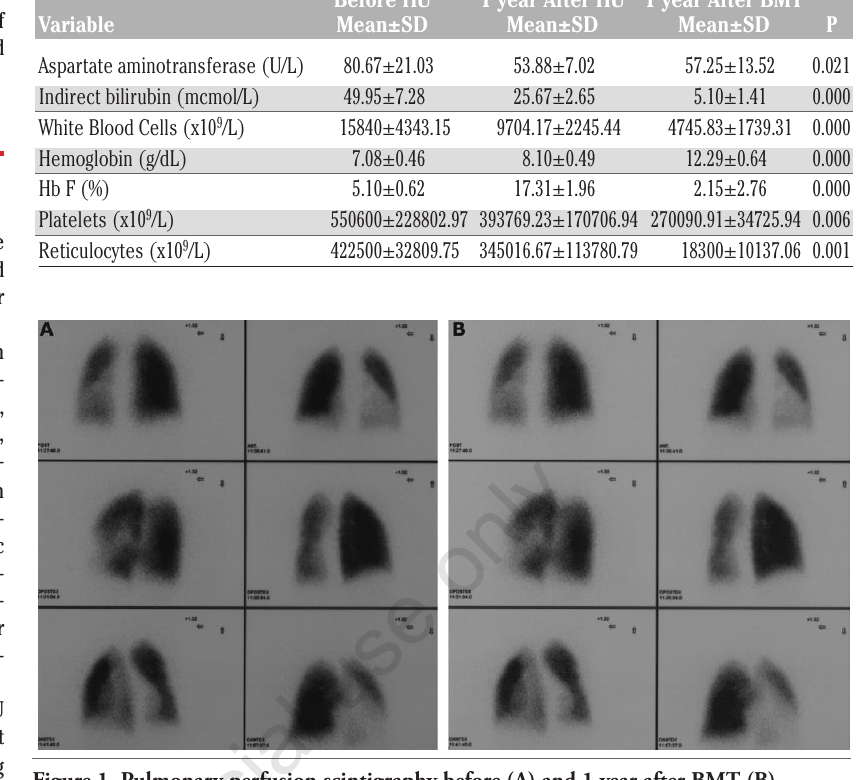
Table 1. Laboratory values before HU treatment, after 1 year of HU treatment and 1 year after bone marrow transplantation. Before